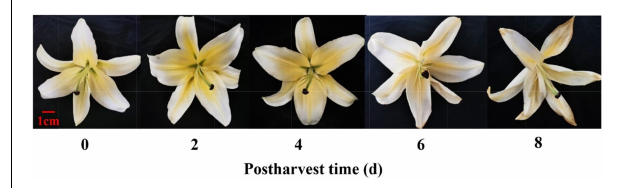
FIGURE 1 | Physical phenotype of cut lily flowers after postharvest. Photographs were taken after postharvest 0, 2, 4, 6, and 8 days,